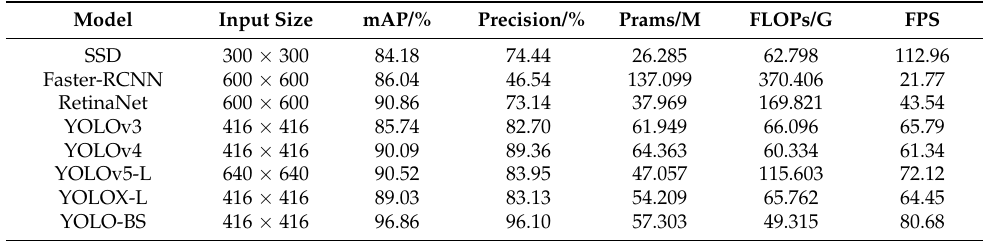
Table 4. Comparison of different network